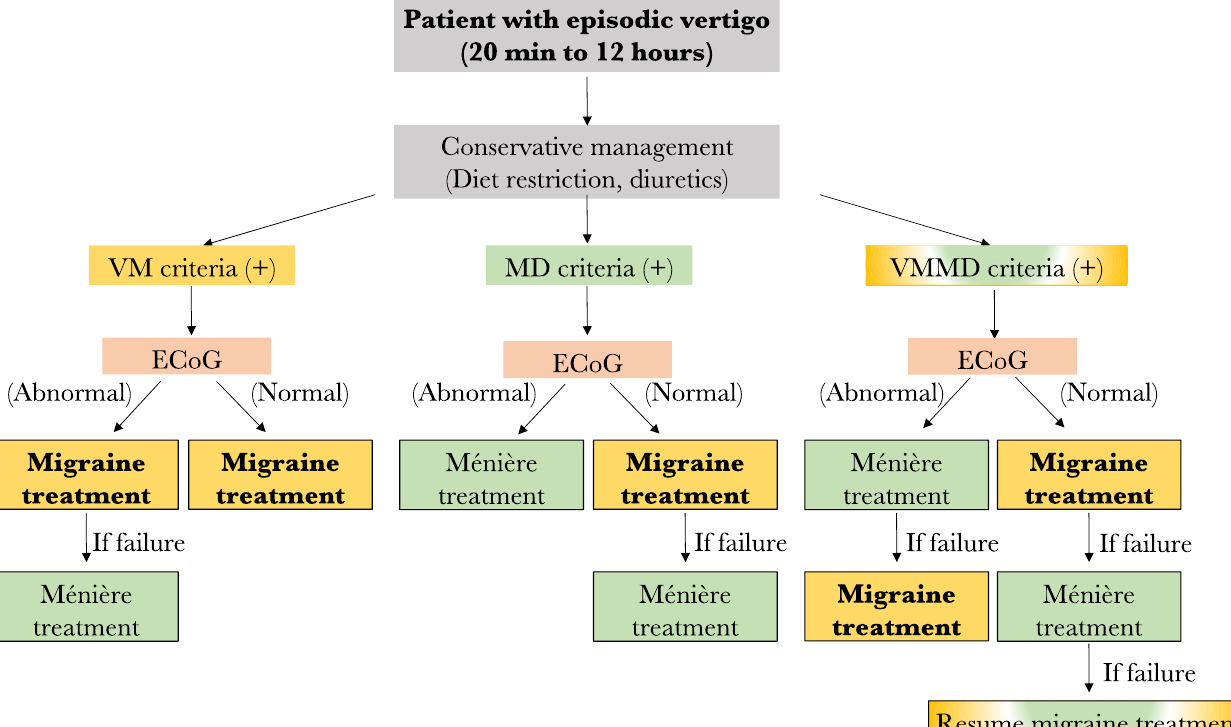
Figure 6. Proposed algorithm for the management of patients with episode vertigo. VM: vestibular migraine; MD: Ménière’s disease; ECoG: electrocochleography (Yellow fr VM, Green for MD,yellow migraine; MD: M é niere’s disease; ECoG: electrocochleography (Yellow fr VM, Green for MD, yellow and green for both diseases). and green for both